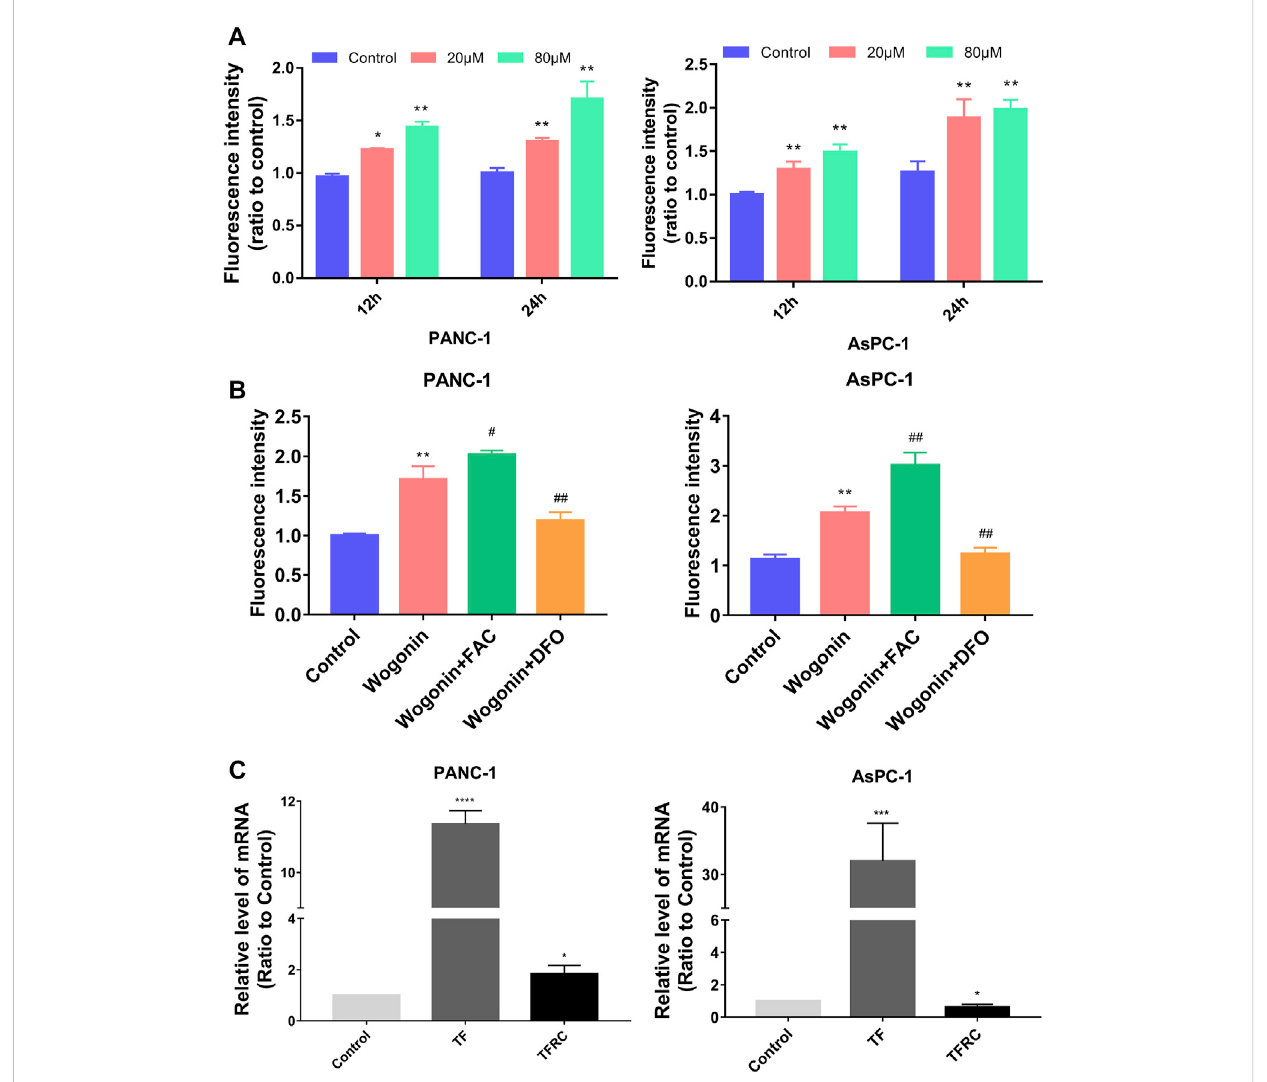
FIGURE 3 Fe 2+ regulated wogonin-induced pancreatic cancer cell death. (A) Intracellular Fe 2+ levels in pancreatic cancer cells. (B) Fe 2+ assay revealed that wogonin-induced increase of ferrous iron was inhibited by deferoxamine (DFO), but reinforced by ferric ammonium citrate (FAC). (C) RT-qPCR analysis revealed that wogonin triggered time-dependent upregulation of transferrin receptor (TFR), transferrin (TF). * p < 0.05 versus control group; **: p < 0.01 versus control group; ***: p < 0.001 versus control group; ****: p < 0.0001 versus control group; # p < 0.05 versus wogonin-alone group; ### p < 0.001 versus wogonin-alone